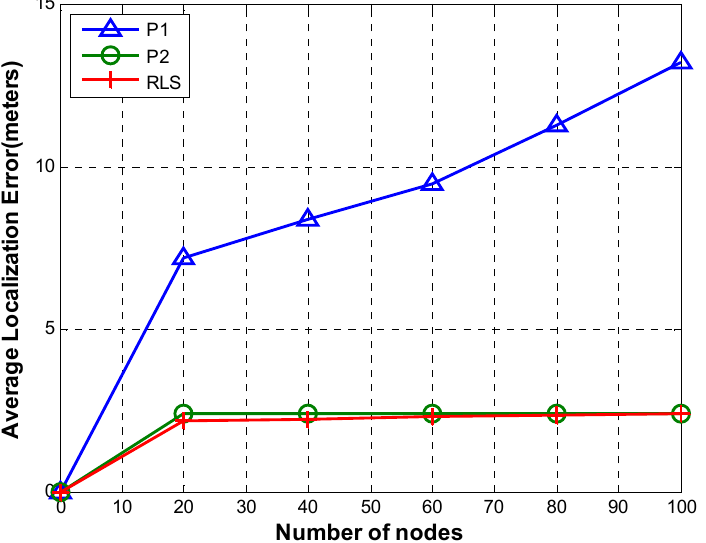
Figure 13. Localization error.